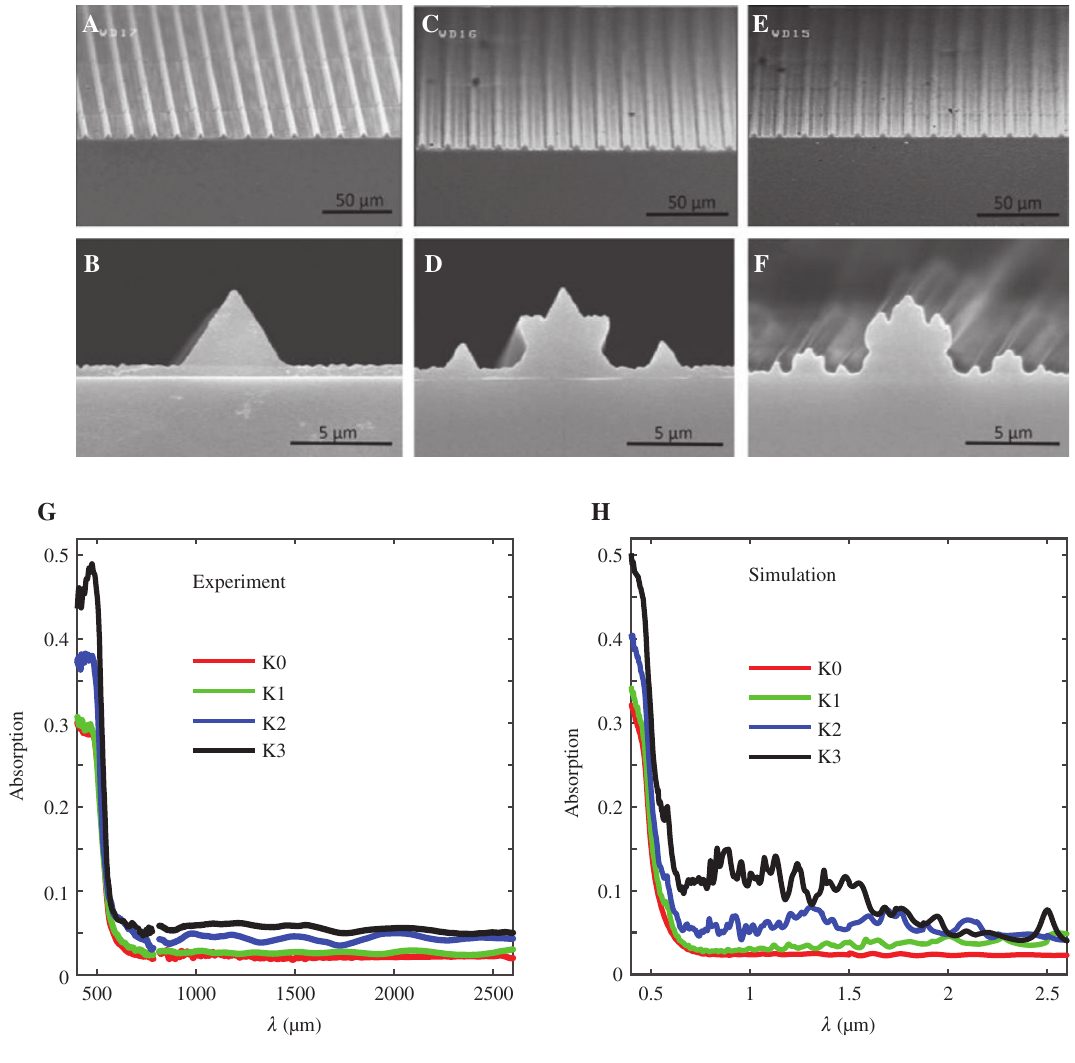
Figure 5: Fabricated samples and absorption characterisation. (A–C) Titled SEM pictures for fractal structures with different orders: (A) K1, (B) K2, and (C) K3. (D–F) The corresponding zoomed-in cross- section pictures with different orders: (D) K1, (E) K2, and (F) K3. (G, H) The absorption spectra from (G) experiment and (H)